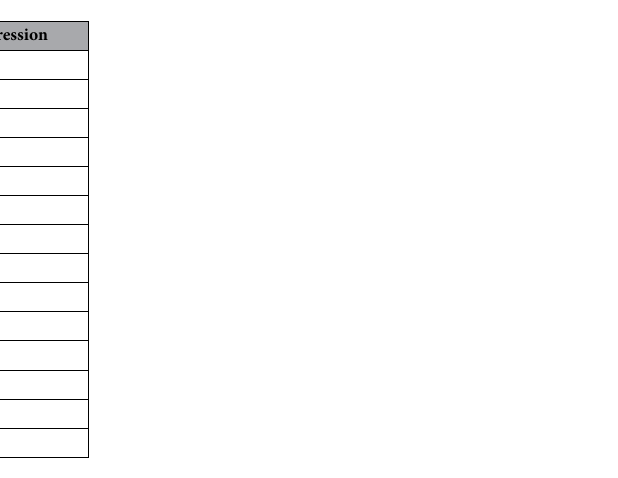
Table 2. Intensity of microRNAs included in exosomes secreted from HepG2